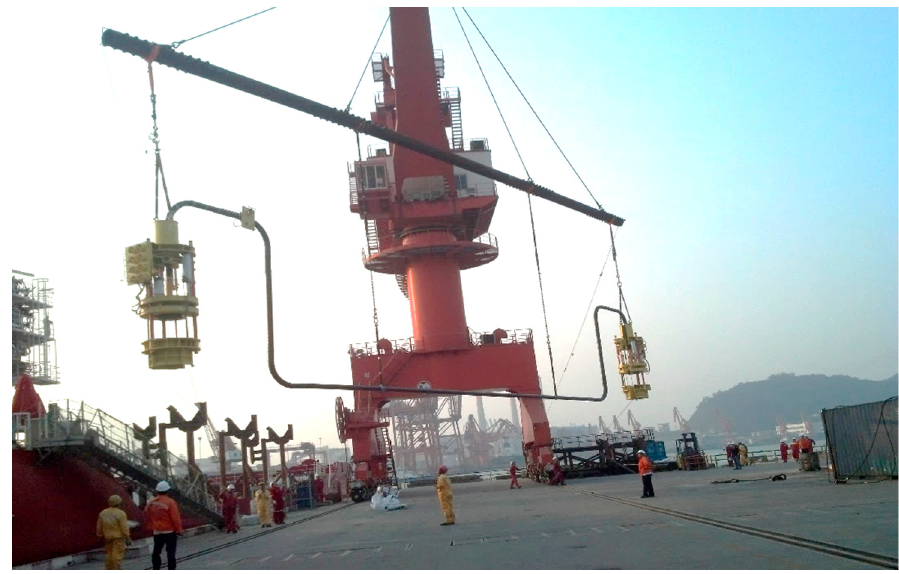
Figure 1. Practical application of the subsea collet connectors (two subsea collet connectors work together).